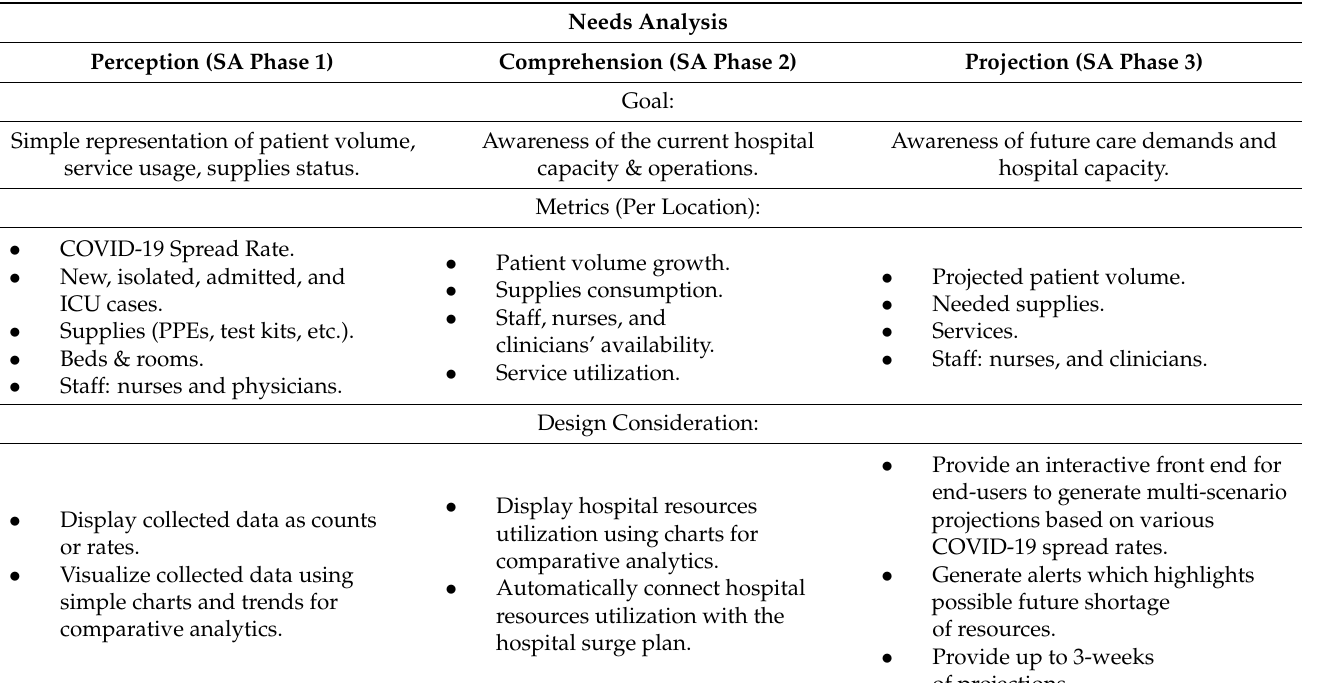
Table 2. Stakeholders Needs